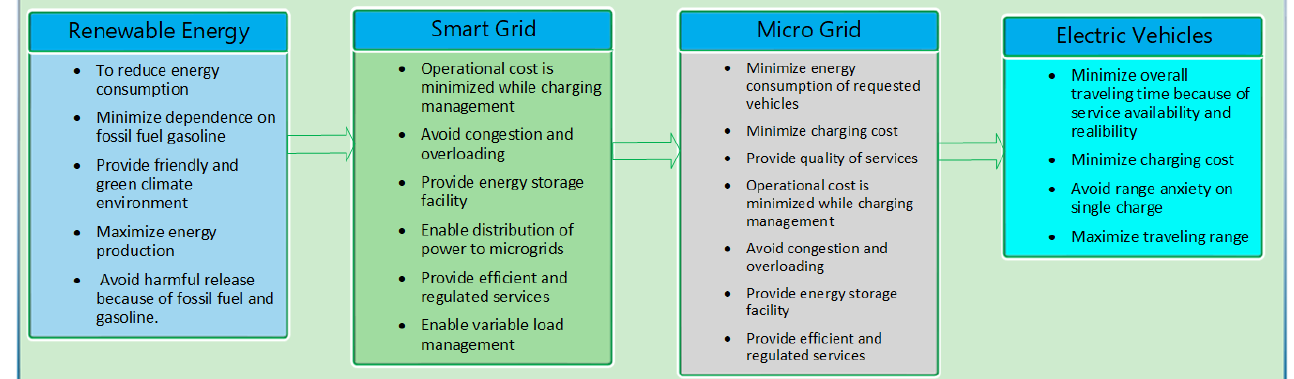
Figure 10. Flow of